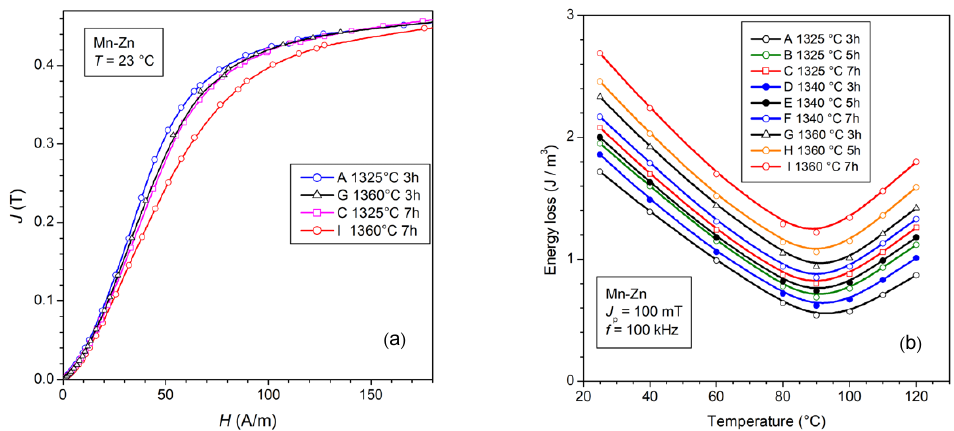
Figure 8. ( a ) Normal magnetization curve of samples sintered at 1325 °C and 1360 °C for different times. ( b ) The energy loss measured at 100 kHz attains minimum value at a temperature of 90 °C upon any sintering circumstance. Treatment at higher temperatures and longer times leads to increased porosity and structural inhomogeneities, aside from a moderate increase in the magnetic anisotropy, all leading to increased losses. (Adapted from Ref. [39]).